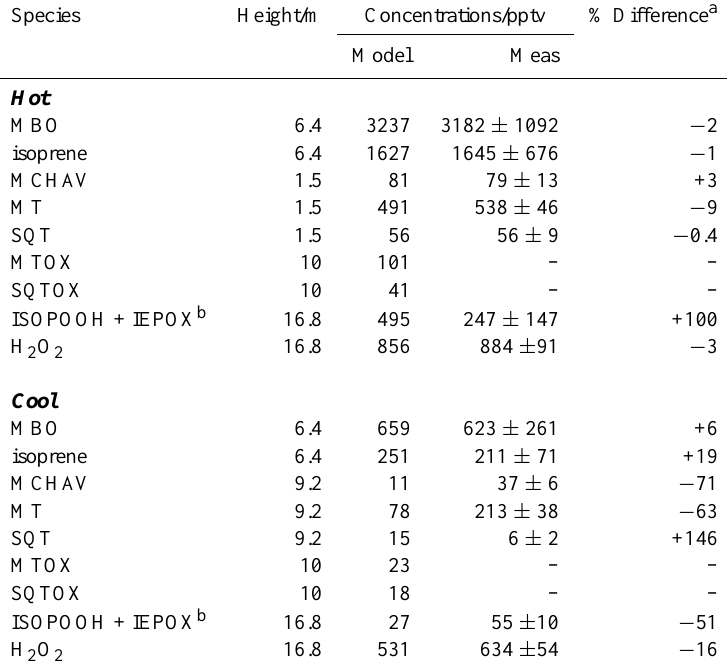
Table 5. Model-measurement comparison of BVOC and peroxides. Model results are taken from the layer closest to the measurement height. Measurements are reported as the mean ± 1 σ